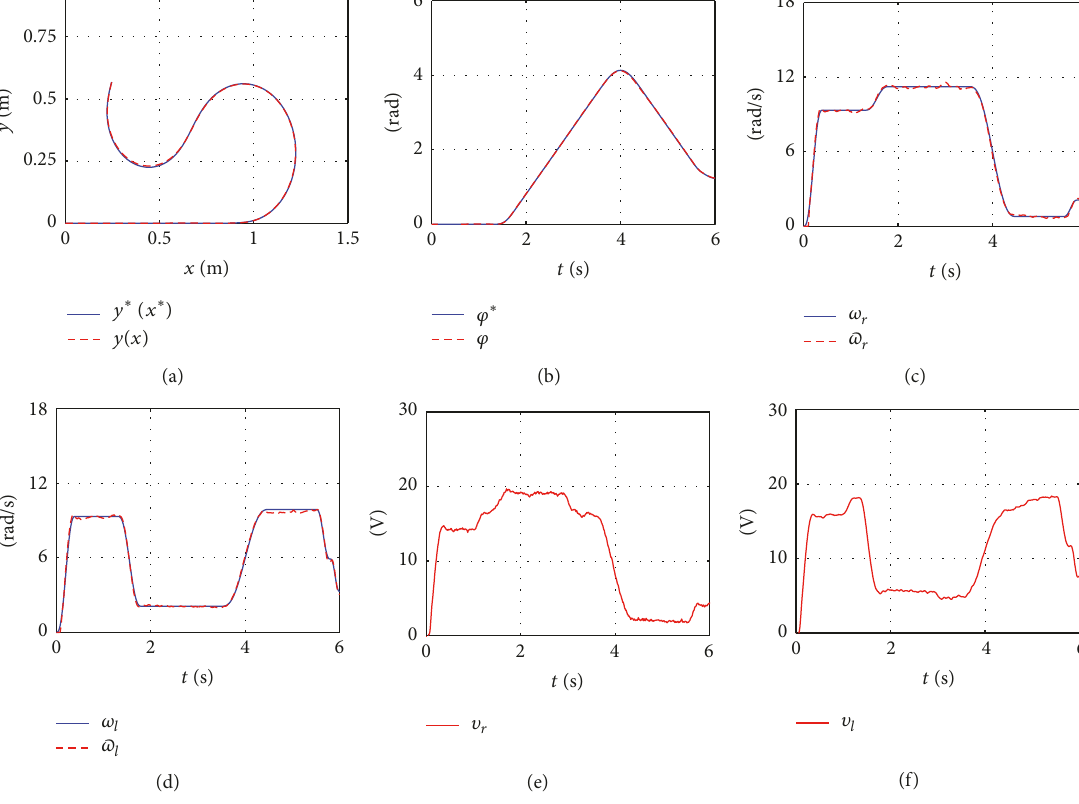
Figure 9: Control objective is accomplished when abrupt changes associated with 𝐸 are small (see Tables 3 and